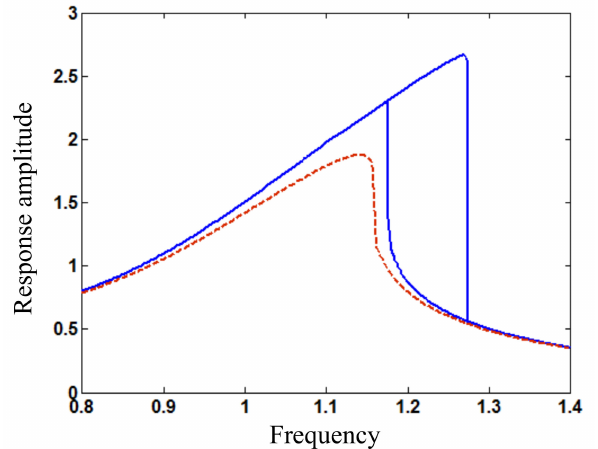
Figure 12. Amplitude ( w Am ) frequency ( ω ) relation around principal resonance for loading amplitude F s 1 = 0.34 and different damping coefficients c (blue solid line: c = 0.1; red dashed line: c = 0.16).